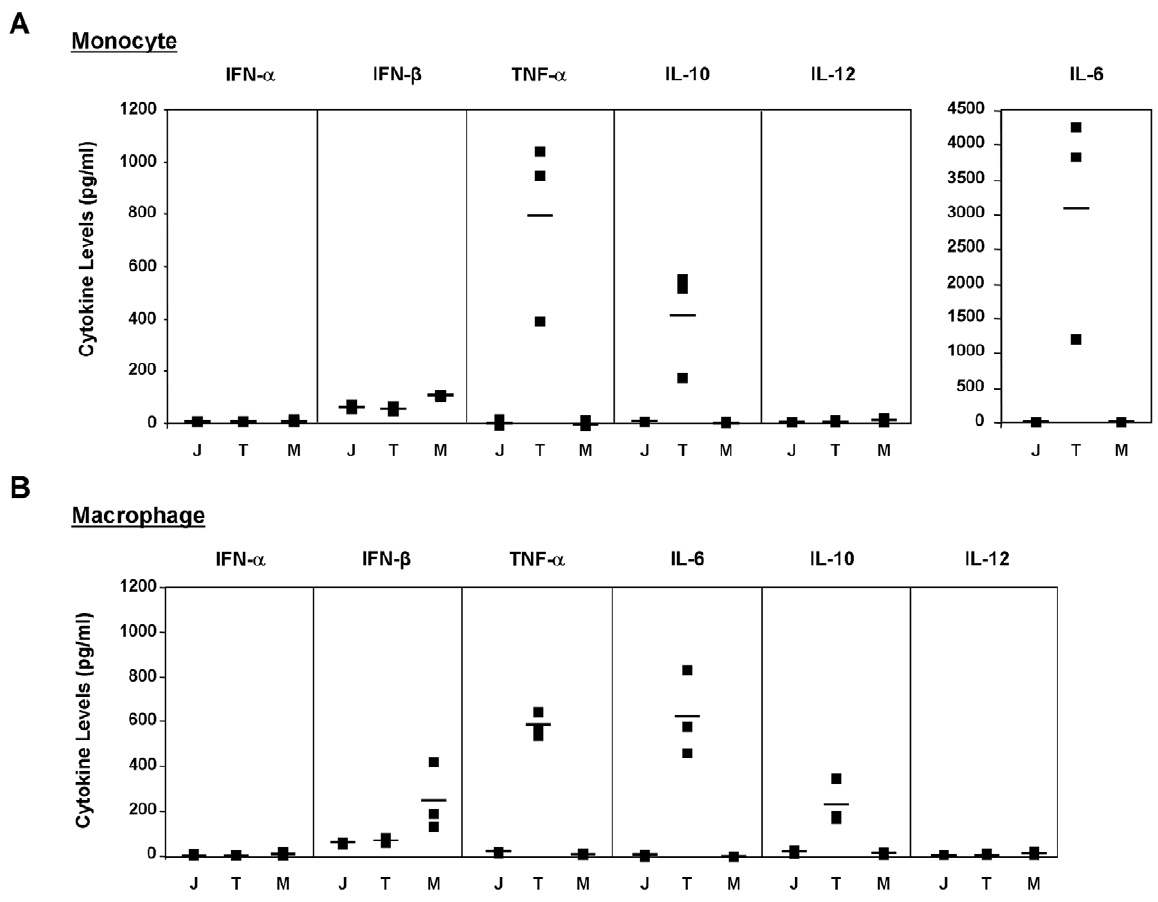
Figure 3. Cytokine production during TCRV and JUNV infection of primary human monocytes and macrophages. (A) Cytokine production during infection of primary human monocytes. Primary human monocytes were infected at an MOI of 0.1 with either TCRV or JUNV or mock infected in a 6-well plate with supernatants collected for cytokine analysis. Supernatants were analysed after 4 days using commercially available cytokine ELISA kits for IFN- a and IFN- b (Pestka Biomedical Laboratories) as well as IL-6, IL-10, IL-12 and TNF- a (R&D Systems) according to the manufacturer’s instructions. The cytokine concentration for each of three donors (black box), as well as the mean for each group (black bar), is indicated for each treatment group: TCRV infected (T), JUNV infected (J) or Mock (M). (B) Cytokine production during infection of primary human macrophages. Primary human macrophages were infected and cytokine analysis performed on collected supernatants as described in (A).